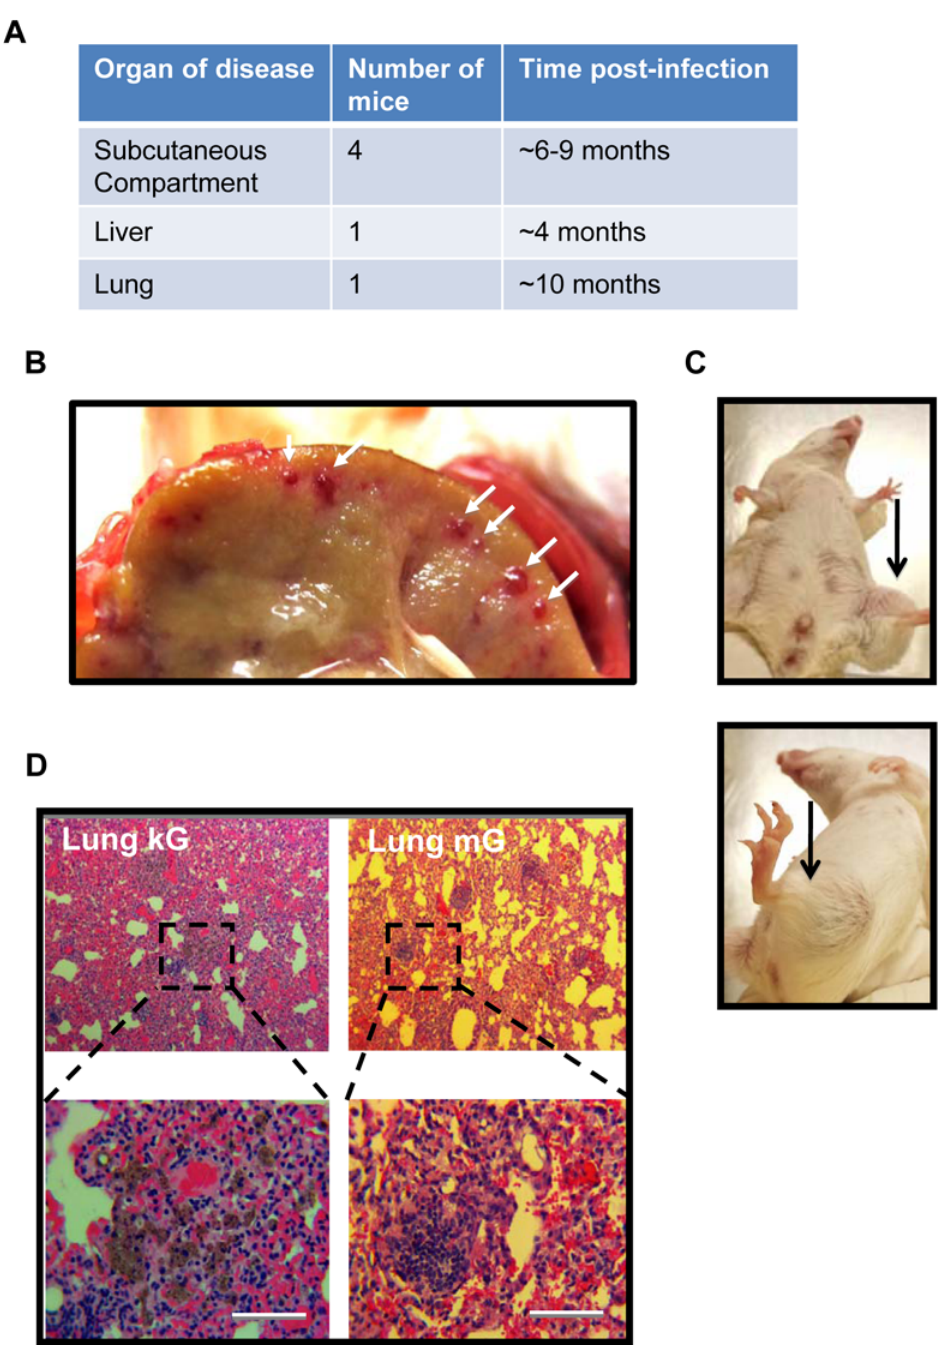
Fig 5. γ HV68.kGPCR infection induces angiogenic lesions in immune-suppressed mouse. Balb/c mice, of six to eight-week-old females, were infected with (1 × 10 5 pfu) via intraperitoneal injection. (A) Summary of 5 mice, out of 15, that demonstrated diseased conditions. One mouse had both subcutaneous tumor and lung fibrosis (shown in D). Mouse liver carrying angiogenic nodule (B) and subcutaneous tumors within the hinder legs (C) were photographed. (D) Lung lesions of mice infected with γ HV68.kGPCR and wild- type γ HV68 analyzed by H&E